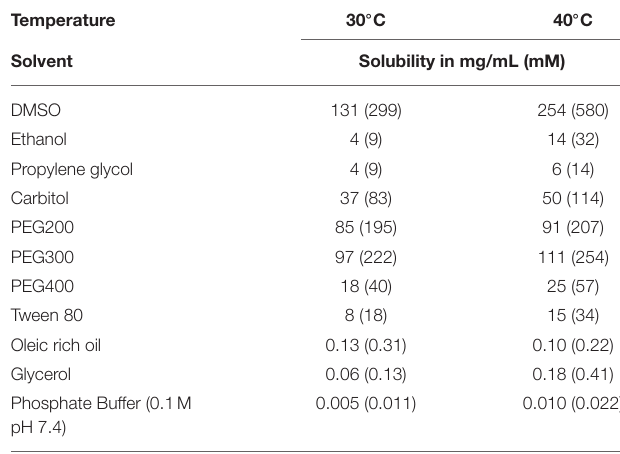
TABLE 5 | cLogP and stability of selected compounds. Stability (% without microsomes) a cLogP